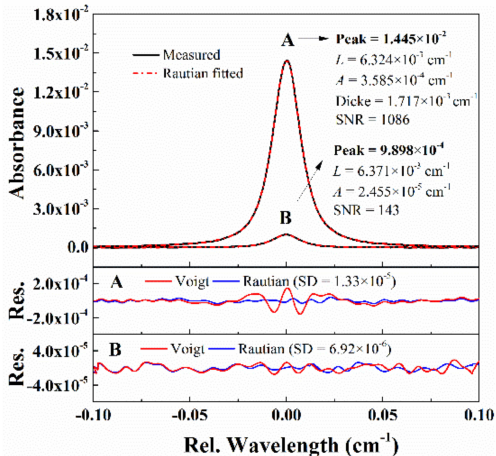
Figure 8. Examples of the recovered absorbance from WM-DAS method under pressure of 11.2 kPa and temperature of 299